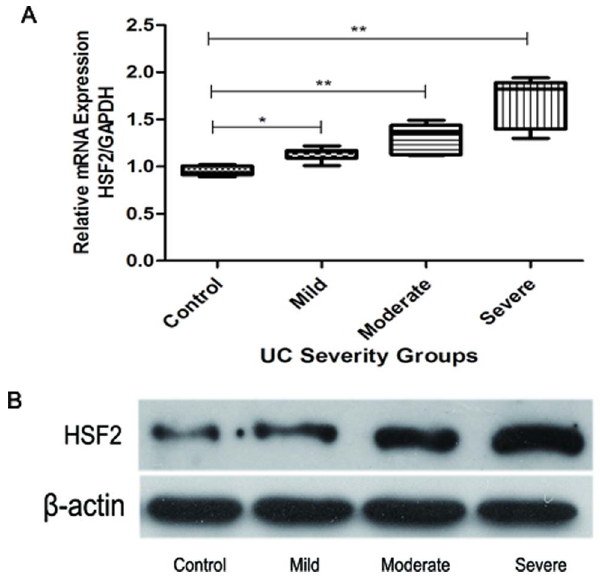
Figure 4. Expression of HSF2 in colonic mucosa tissues of UC was examined by real- time PCR and Western Blotting. A : the mRNA transcriptional levels of UC groups of varying severity. The data from the real-time PCR were analyzed with the delta–delta Ct method and normalized to the amount of GAPDH cDNA as an endogenous control. B: the protein expression levels of different UC severity groups, b -actin as an endogenous control. *, p , 0.05; **, p , 0.01.